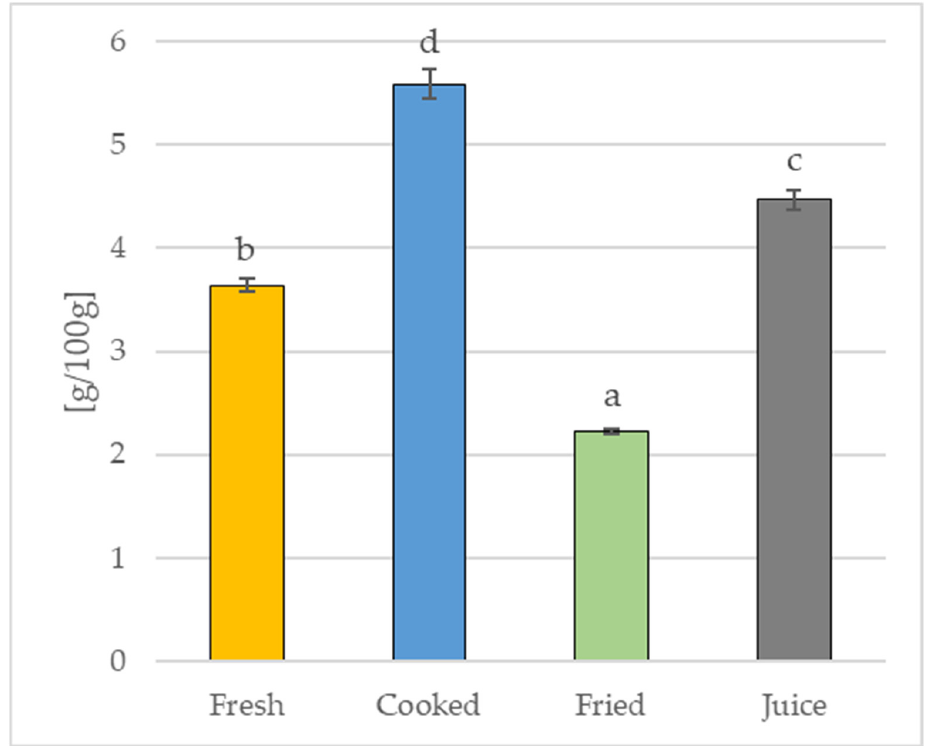
Figure 2. Tannin content in fresh quince fruit and its products. Mean values ( n = 3) marked in bars by di ff erent le tt ers di ff er signi fi cantly (Duncan’s test, p ≤ 0.05).